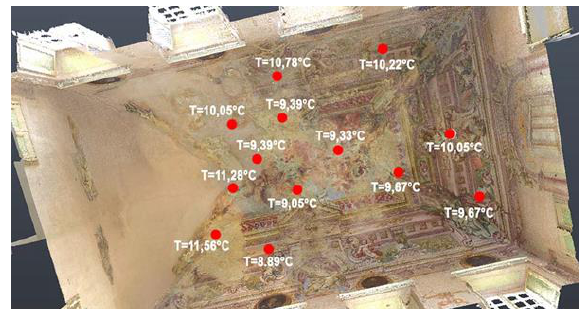
Figura 13. Temperature distribution to the intrados of the vault detected with a thermal imaging camera.